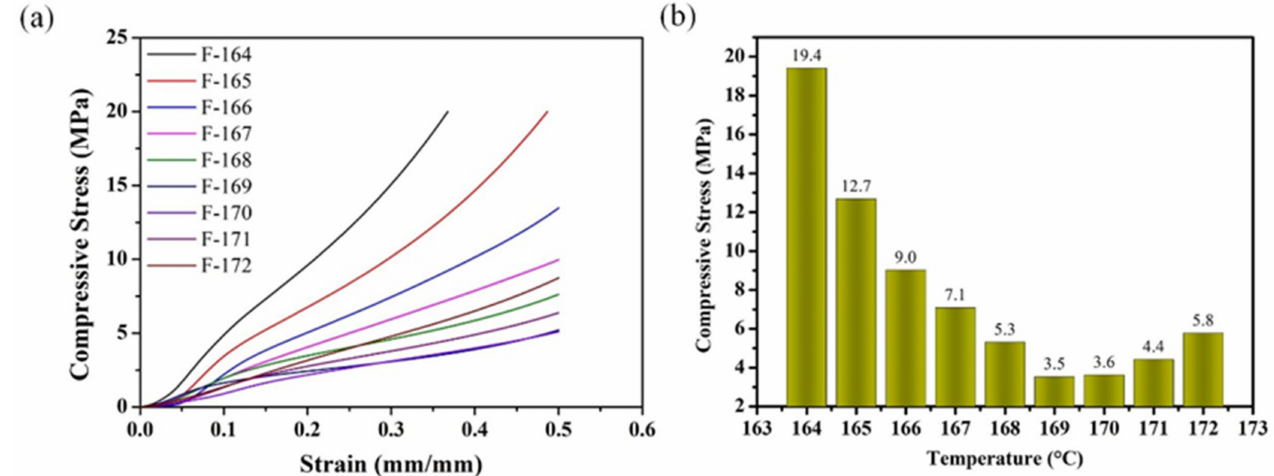
Figure 9. ( a ) The compressive stress-strain curves of PVDF/CNTs/Ni composites foamed at different saturation temperatures; ( b ) The compressive strength of composite foams at 30%